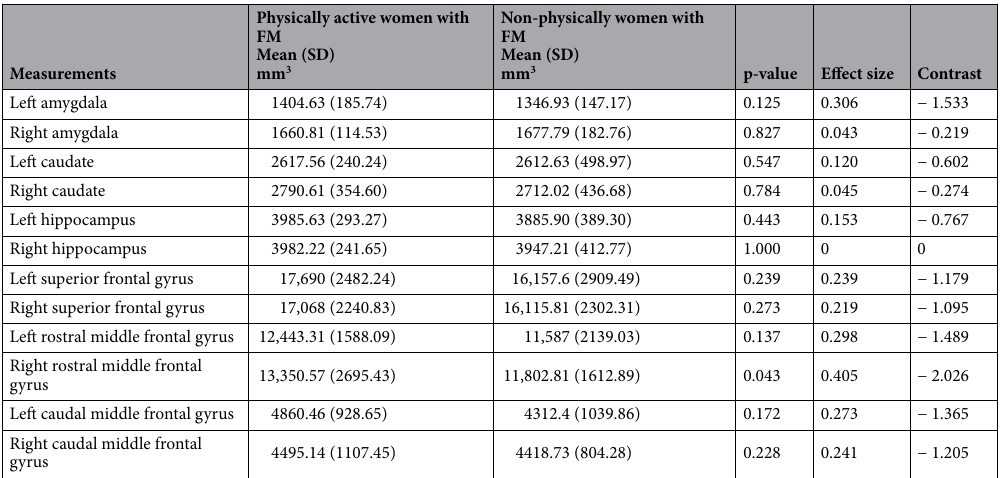
Table 3. Volumetric differences between physically and non-physically active women with